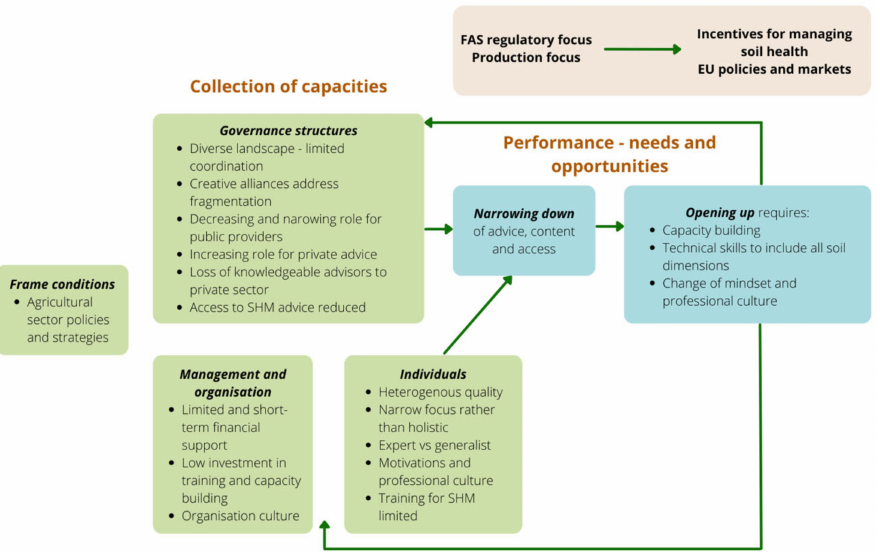
Figure 2. This figure shows how the collection of capacities act to narrow down the nature and extent of advice for soil. Changing needs and opportunities will open up the scope of advice for delivering